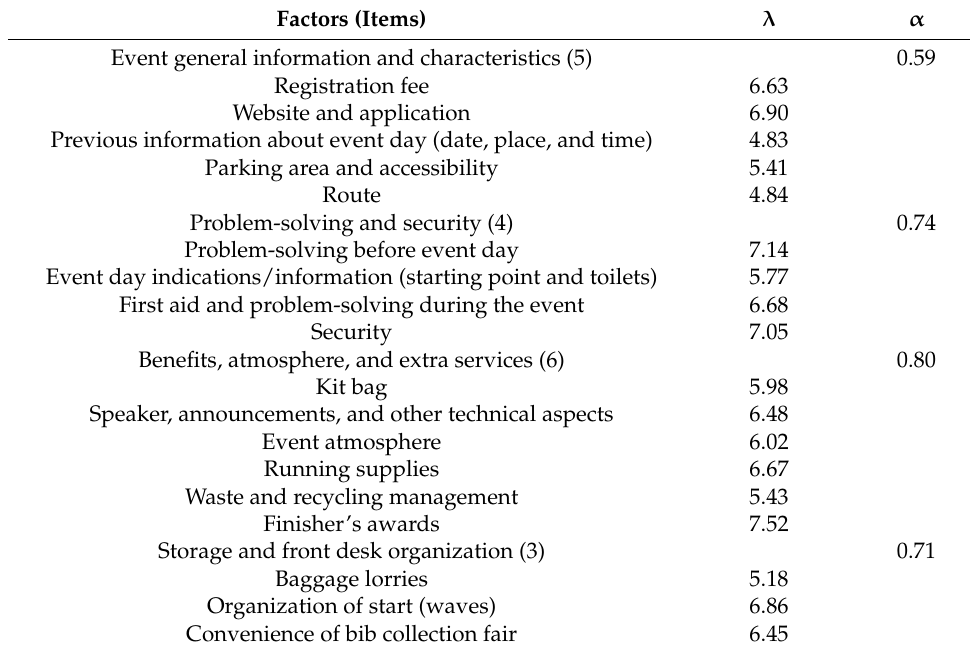
Table 3. Factorial analysis: final factor loadings ( λ ) and Cronbach’s alpha ( α ) for importance items.